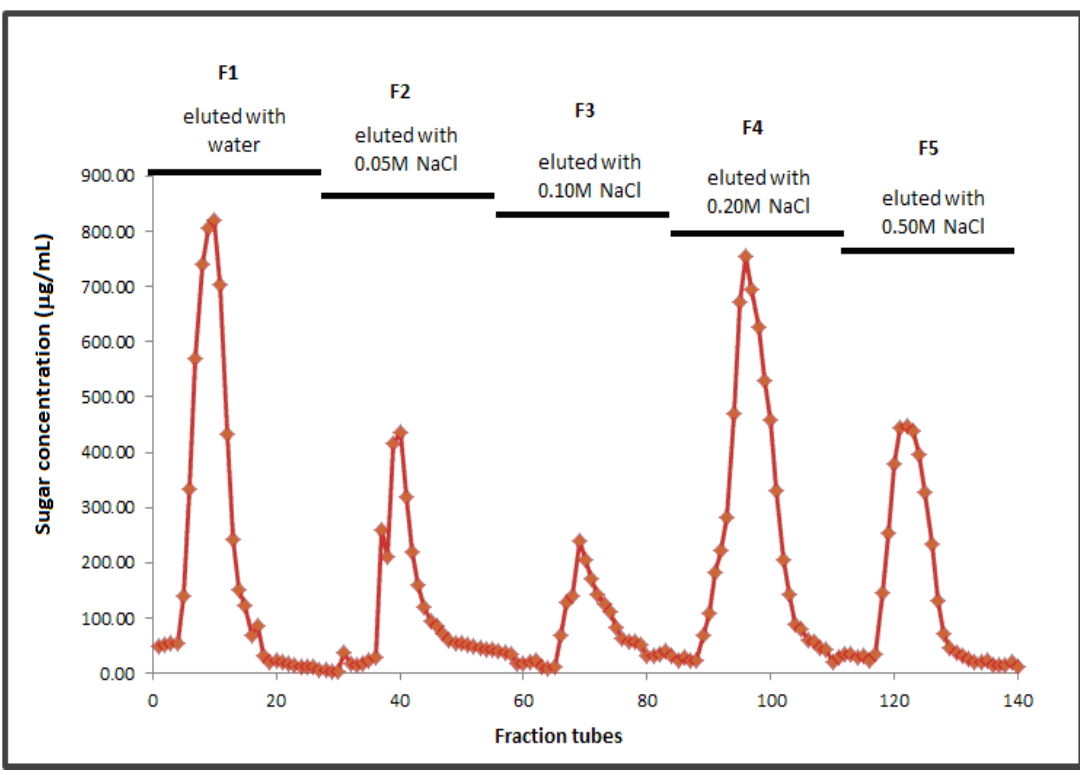
Figure 1. Anion-exchange chromatogram of BSCP (F1: Neutral polysaccharides–eluted with water; F2–F5: Acidic polysaccharide-eluted by salt gradient